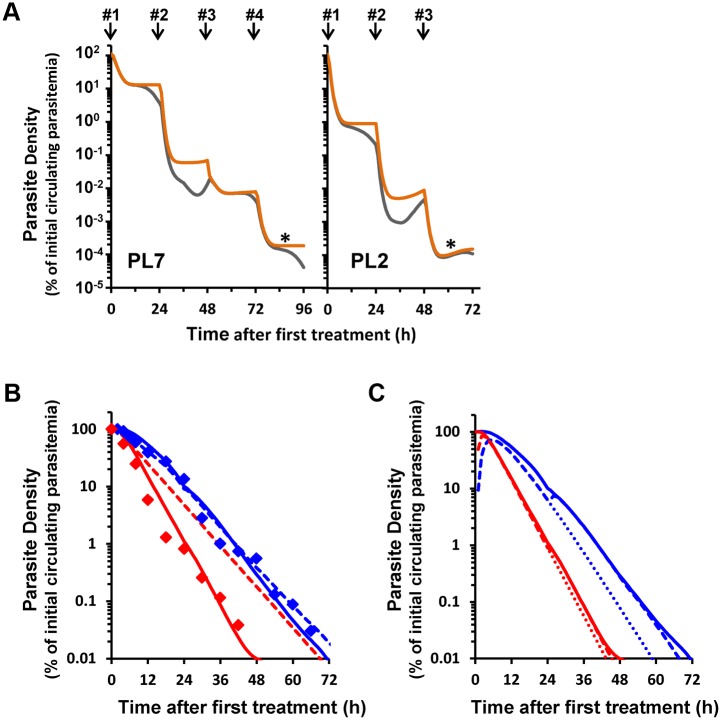
Delayed parasite clearance of resistant strains reflects both reduced killing and delayed removal of unviable parasites.(A) Viable parasite load during DHA treatment regimen. The number of total (circulating and sequestered; orange curves) and circulating (grey curves) viable parasites during DHA therapy in hypothetical patients presenting with ring-stage PL7- and PL2-like infections were simulated using CED model parameters and an in vivo DHA pharmacokinetic profile (see S1 Appendix, S3 Table). Arrows indicate the times of drug administration. (B) Influence of unviable parasite removal on parasite clearance profiles. The circulating unviable parasites in (A) in the PL2 and PL7-like infections (red and blue curves, respectively) were modelled to disappear from circulation with a half-life of 5 h (dashed curves) or exhibit more complex removal (solid curves) involving strain-dependent (1- and 3.5-h half-lives for PL2 and PL7), in addition to a strain-independent (3-h half-life) component. Symbols correspond to median circulating parasite loads from patients in Pailin (blue) and Wang Pha (red) [41]. (C) Contribution of unviable parasites to parasite clearance curves. The solid curves represent the simulated parasite clearance curves shown in Fig 7B incorporating the complex clearance of unviable parasites. The dashed curves correspond to the total number of unviable parasites at each time point and the dotted curves to the unviable parasites produced during the course of the first treatment (i.e., formed during the first 24 h).